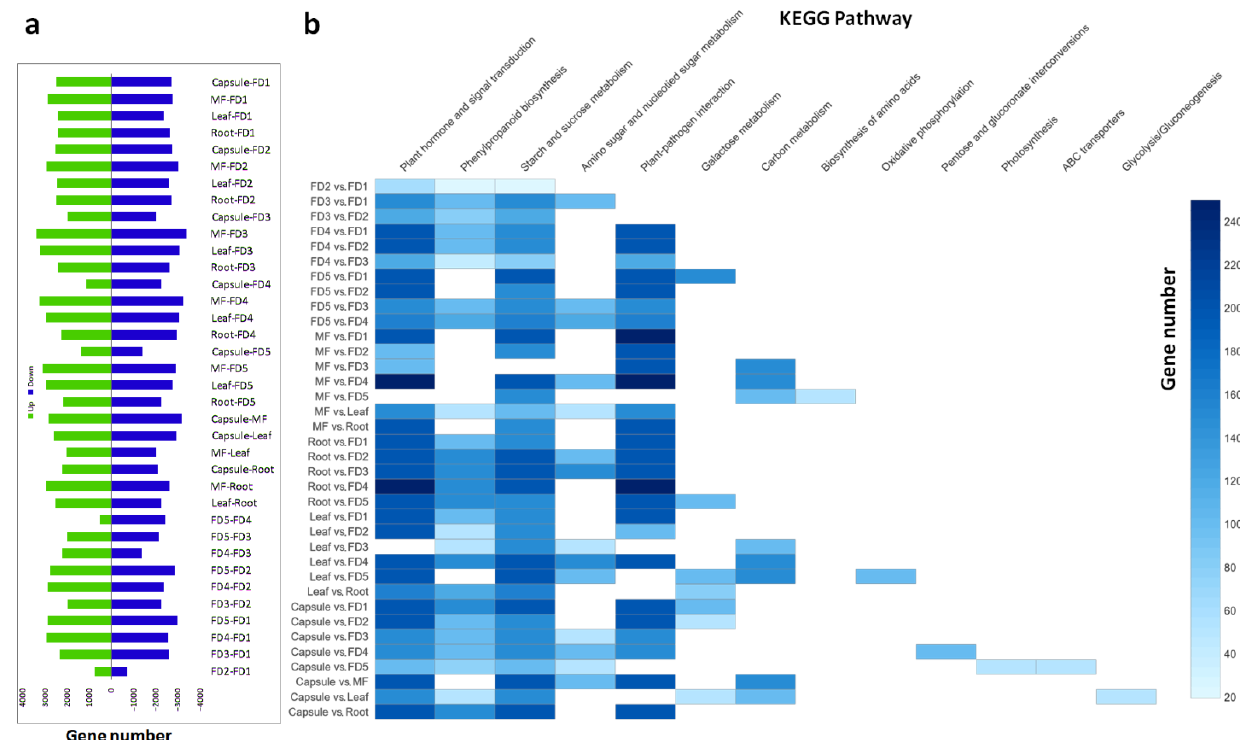
Figure 1. Principal component analysis ( a ) and Pearson correlation coefficient analysis ( b ).